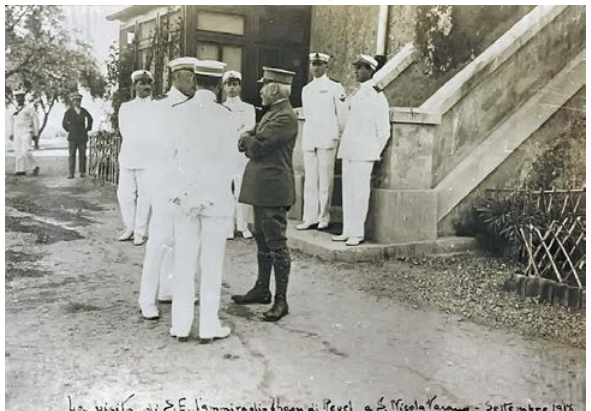
Figure 3. Officers and Admiral Thaon de Revel, visiting 13 sett.1917